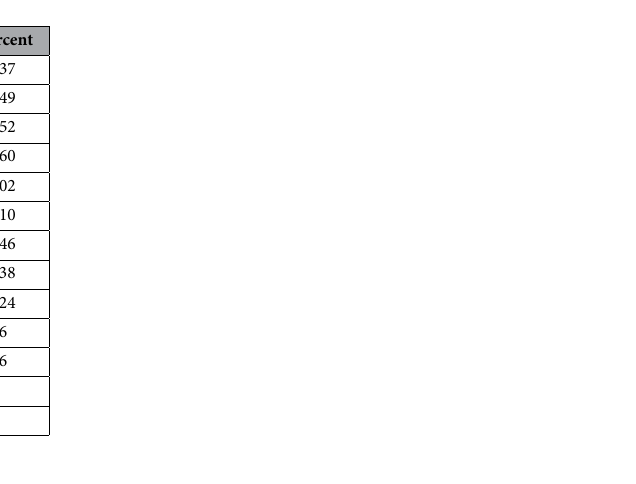
Table 6. Details of the